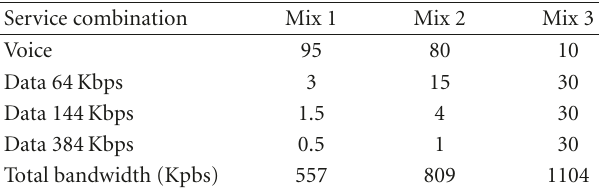
Table 9: Services mixtures in [26]. Table 10: Comparison of the resulting cell